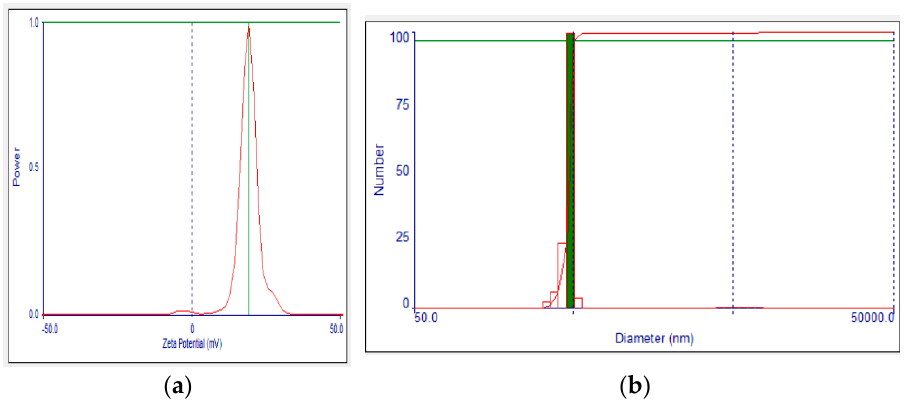
Figure 5. Average particle size distribution ( a ) and zeta potential graphs ( b ) of optimized CEO-CSNPs.